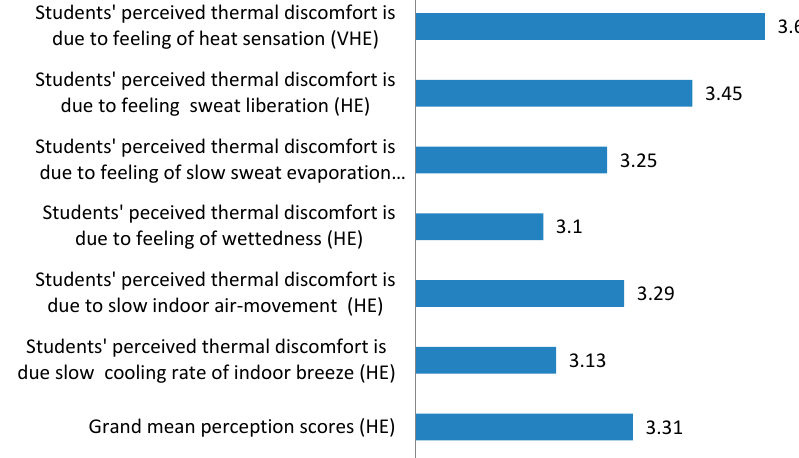
Table 2. Measurement of indoor space and environmental conditions in LTH ‐ 3.